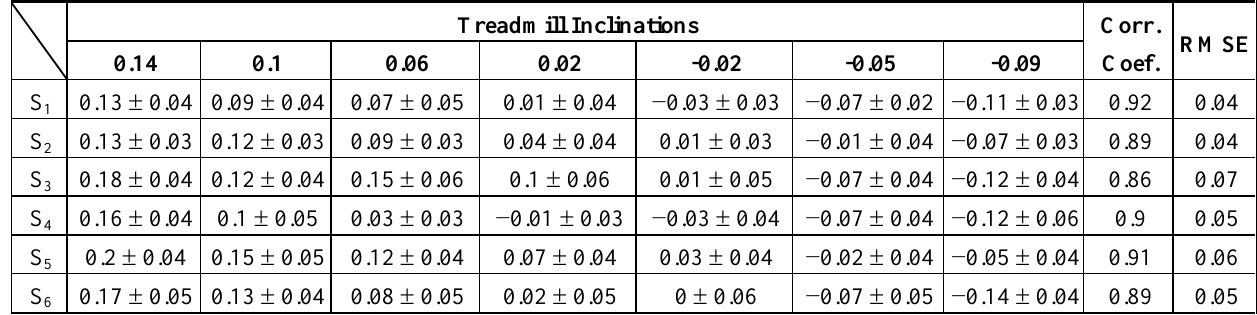
Table 1. Numerical results (raw estimations) of the experiments. S Average and standard deviation of estimations are shown for every subject and treadmill inclination. Linear correlation coefficient values (correlation coefficient of Pearson) between estimations and actual inclination of the treadmill and root mean squared error (RMSE) of estimations are also shown for each